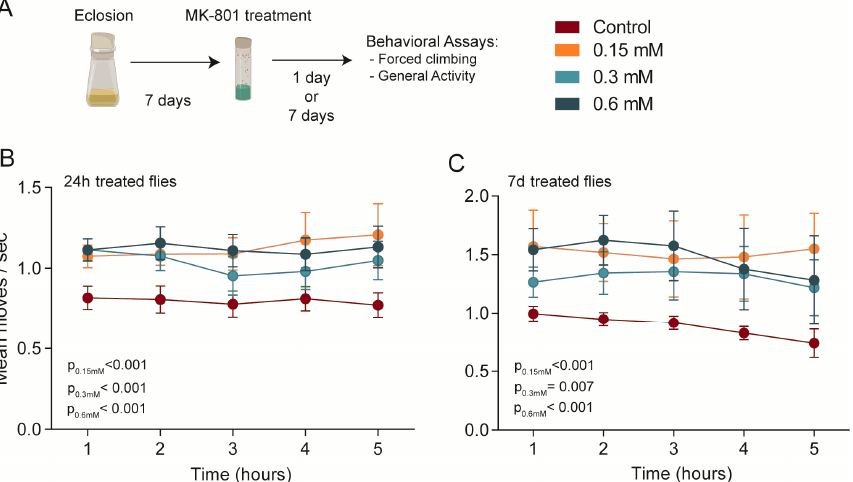
Figure 1. NMDA inhibition effects on Drosophila melanogaster climbing behaviour. ( A ) Protocol for acute (24 h) or chronic (7 days) MK-801 pharmacological treatment and subsequent behavioural testing. ( B ) 24 h treated and ( C ) 7 d treated flies showed increased locomotion in the forced climbing test. Two-way ANOVA analysis was used for forced climbing (24 h intake: n [all groups] = 16; 7 d intake n [all groups] = 8). Values are shown as mean ± SEM.